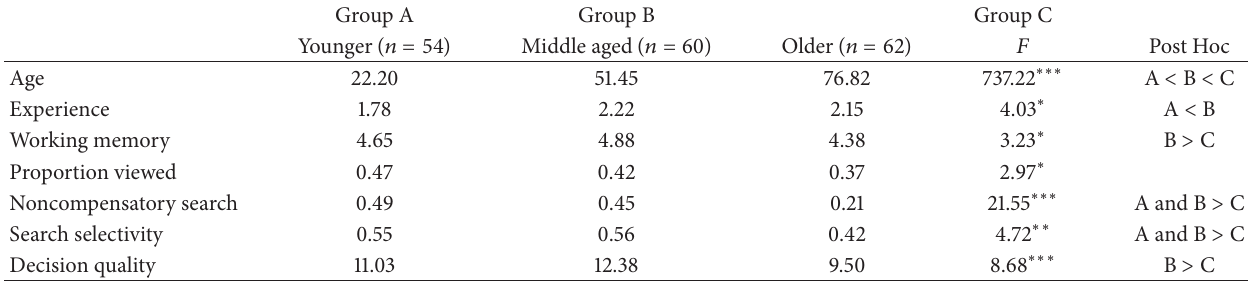
Table 2: Mean age group differences.